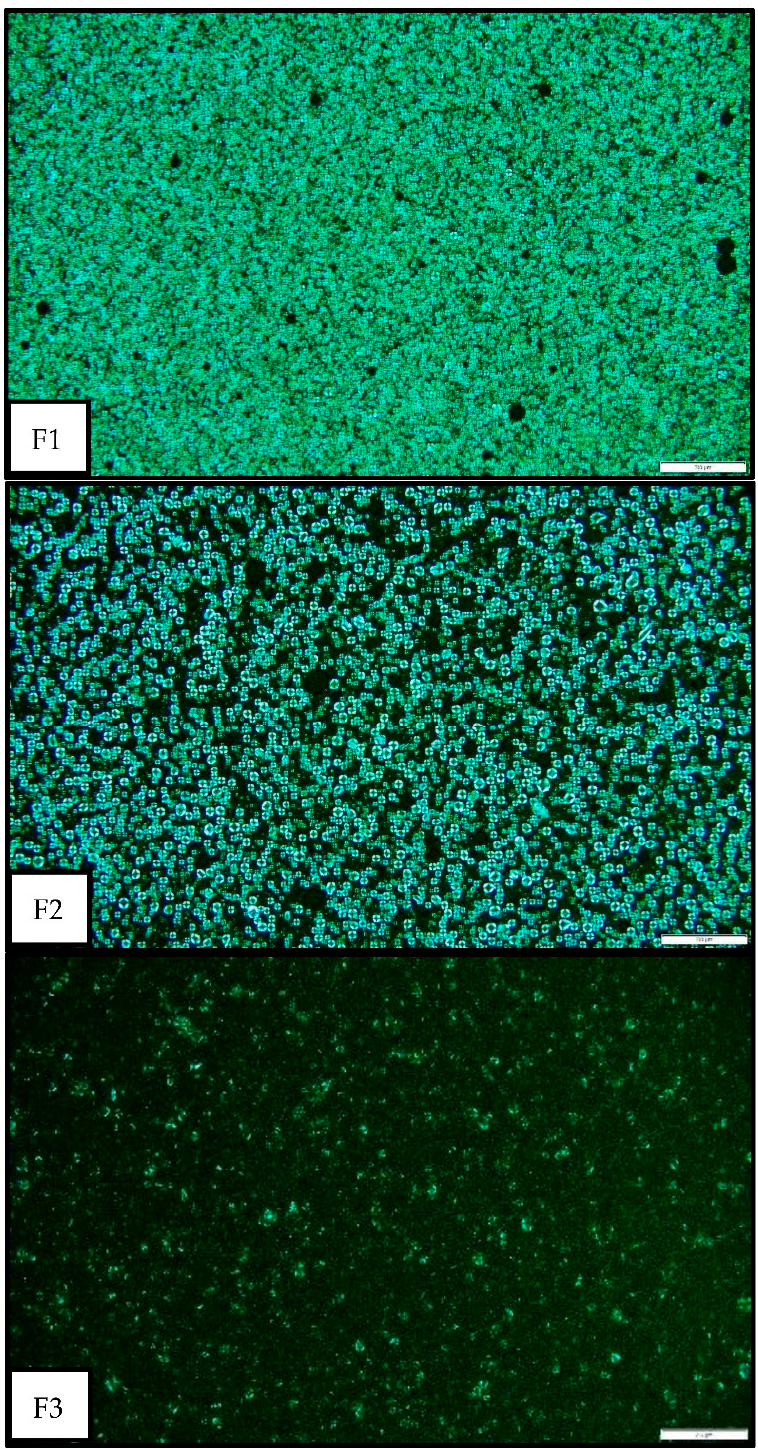
Figure 3. Polarized light microscopy photomicrographs (100 × magnification) of the developed products (without and with germinated brown rice extract F1 and F2, respectively) and a liquid crystal cream from a counter brand (F3).